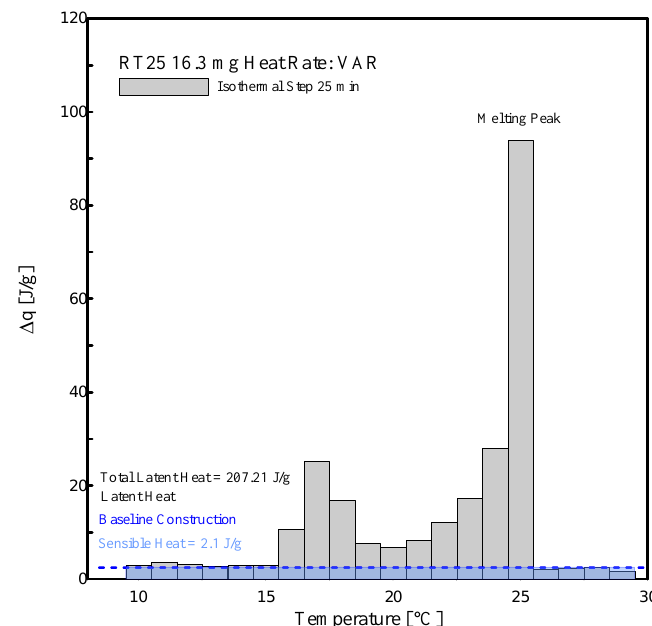
Figure 17. Histogram view of stored heat ∆ q (T) for RT25, at several temperature intervals and adopting an isothermal time step of 25 min.